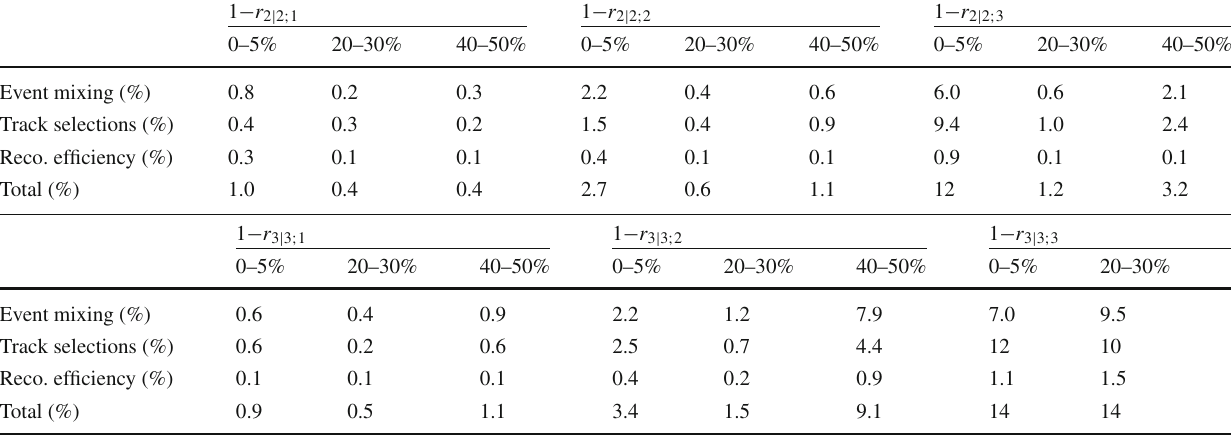
uncertainties in percent for 1 − R 2 | 2 ; 2 , 1 − R 3 | 3 ; 2 , 1 − r 4 | 4 ; 1 and 1 − r 5 | 5 ; 1 at η = 1 . 2 in selected centrality